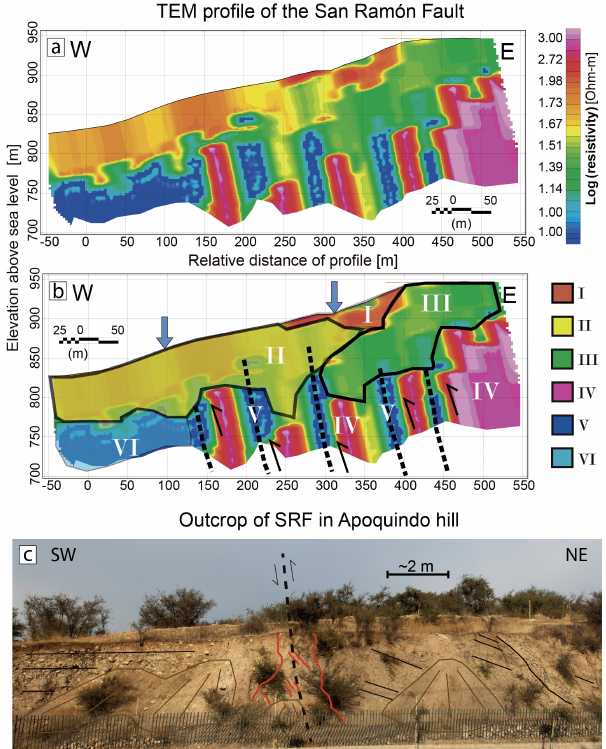
Figure 3. TEM results and the Apoquindo hill outcrop. (a) TEM inversion results. (b) Interpretation of the TEM profile. The blue arrow indicates the fault scarp in surface, and the roman numbers are the different lithologic units described in detail in the Sect. 4.2 TEM results. The location of the profile can be found in Supple- ment Fig. S1. (c) Apoquindo hill outcrop constituted by quaternary sediments (location in Fig. 1). The continuous black lines represent the dip of the strata. On the SW side, imbricated fluvial sediments show horizontal stratification. On the NE side, we can observe tilt- ing against the natural slope of the sediment strata. This tilting is produced by the SRF, enclosed in the red line, with the reverse kine- matic represented by the dashed line in black. The fault cuts quater- nary sediments. The colluvial formed by the breakdown clasts is shown in brown. A better-resolution image with a close up of the differences in lithologic units can be found in Supplement Fig.